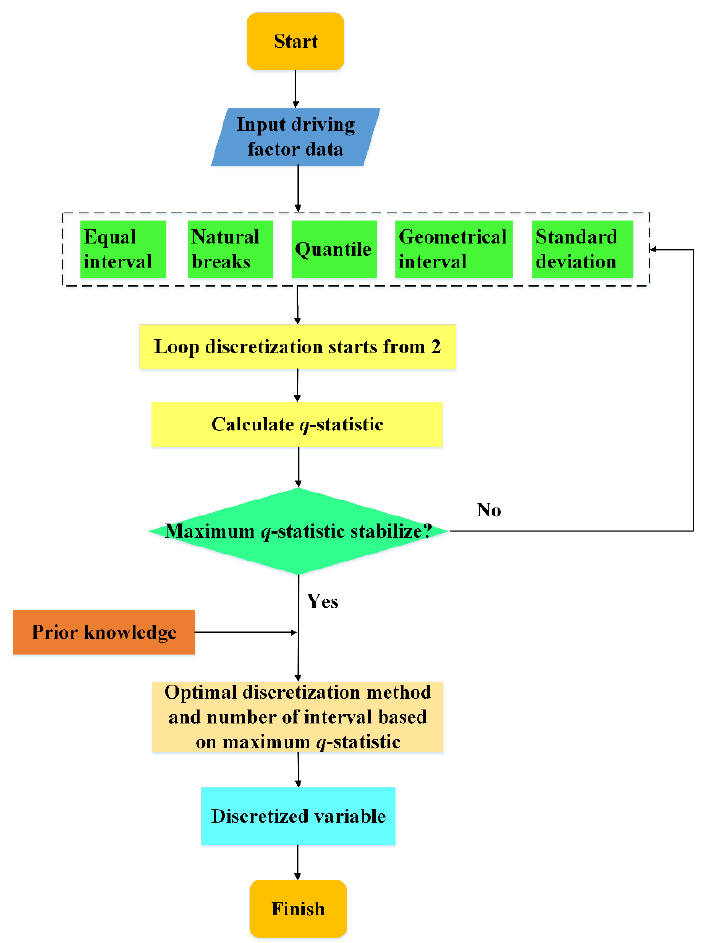
Figure 5. Flowchart illustrating the process of determining the optimal discretization method and stratification number.